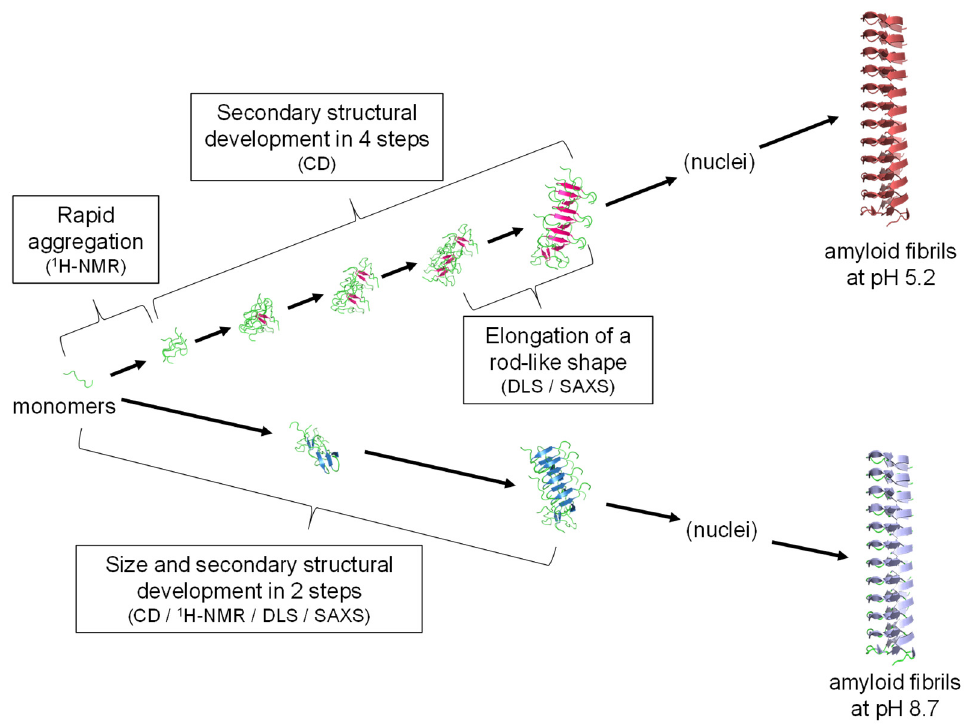
Figure 7. Schematic illustration representing prefibrillar aggregate-mediated amyloid formation of B chain. Two different pathways observed at pH 5.2 and pH 8.7 are shown at the top and bottom of this figure, respectively.